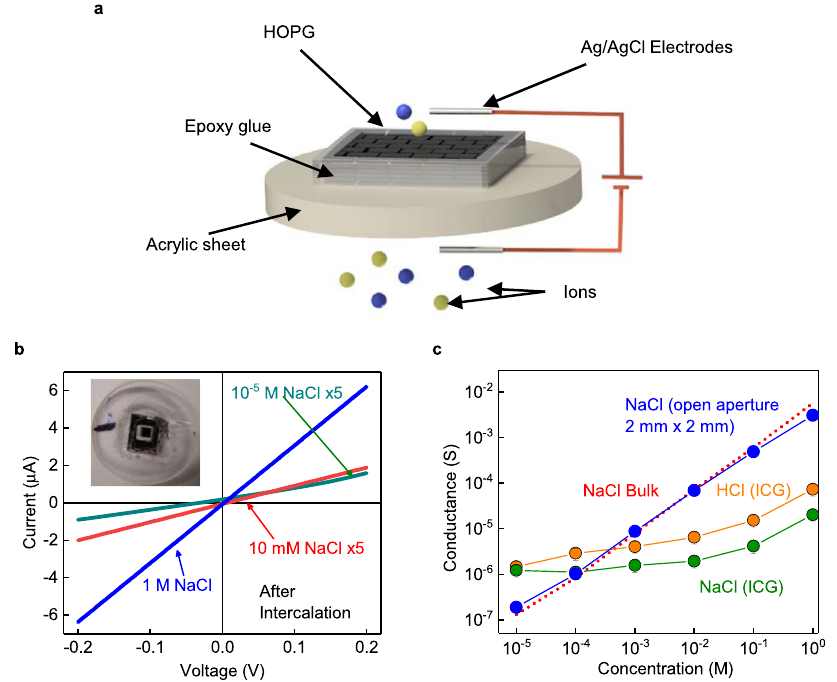
Fig. 1 Ion-transport through intercalated graphite (ICG). a Schematic of our ion-transport measurement setup. b I – V characteristics of ICG with an equal concentration of NaCl in both reservoirs. The top inset shows an actual ICG device. NaCl concentrations vary from 10 − 5 M to 1 M. c Conductance of ICG for both HCl and NaCl, along with the data from the open aperture support (blue spheres) of area 2 mm × 2 mm and the effective thickness of 0.25 mm. Error bars provide the standard deviation between repeated measurements. The red dotted curve corresponds to standard data taken from literature 31 . The conductance of ICG at 1 M NaCl concentration is ~3 orders of magnitude smaller than that of